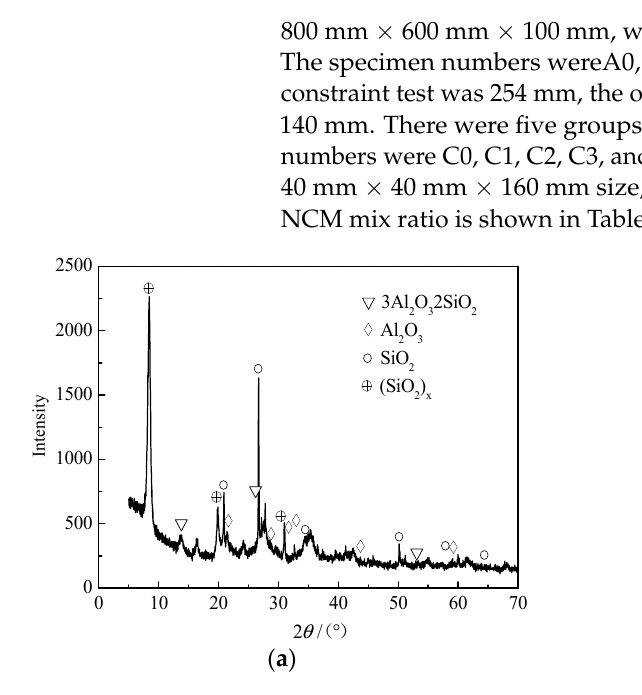
Figure 1. XRD spectra of nanoclay: ( a ) NMA; ( b ) NMK. Table 3. Mix proportion of cement